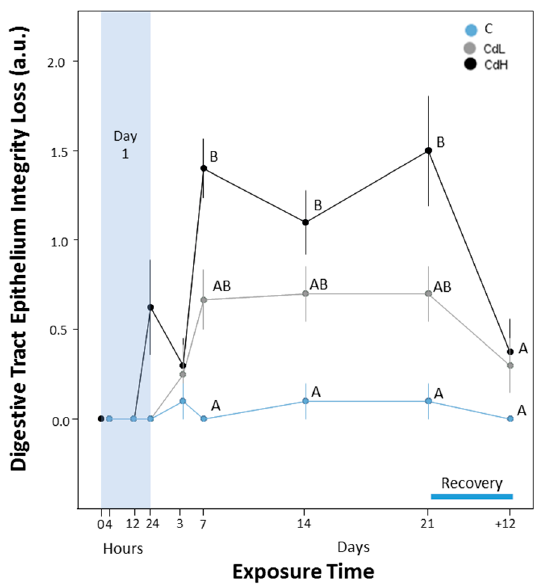
Figure 11. Course of the integrity loss of the epithelia of digestive tract (DTI), expressed in arbitrary units (a.u.) (see Table 1 in the Materials and Methods section for explanation). Means (symbols) and standard errors (bars) are shown. Different letter codes between single values of the same time point indicate statistically significant differences ( p < 0.05).